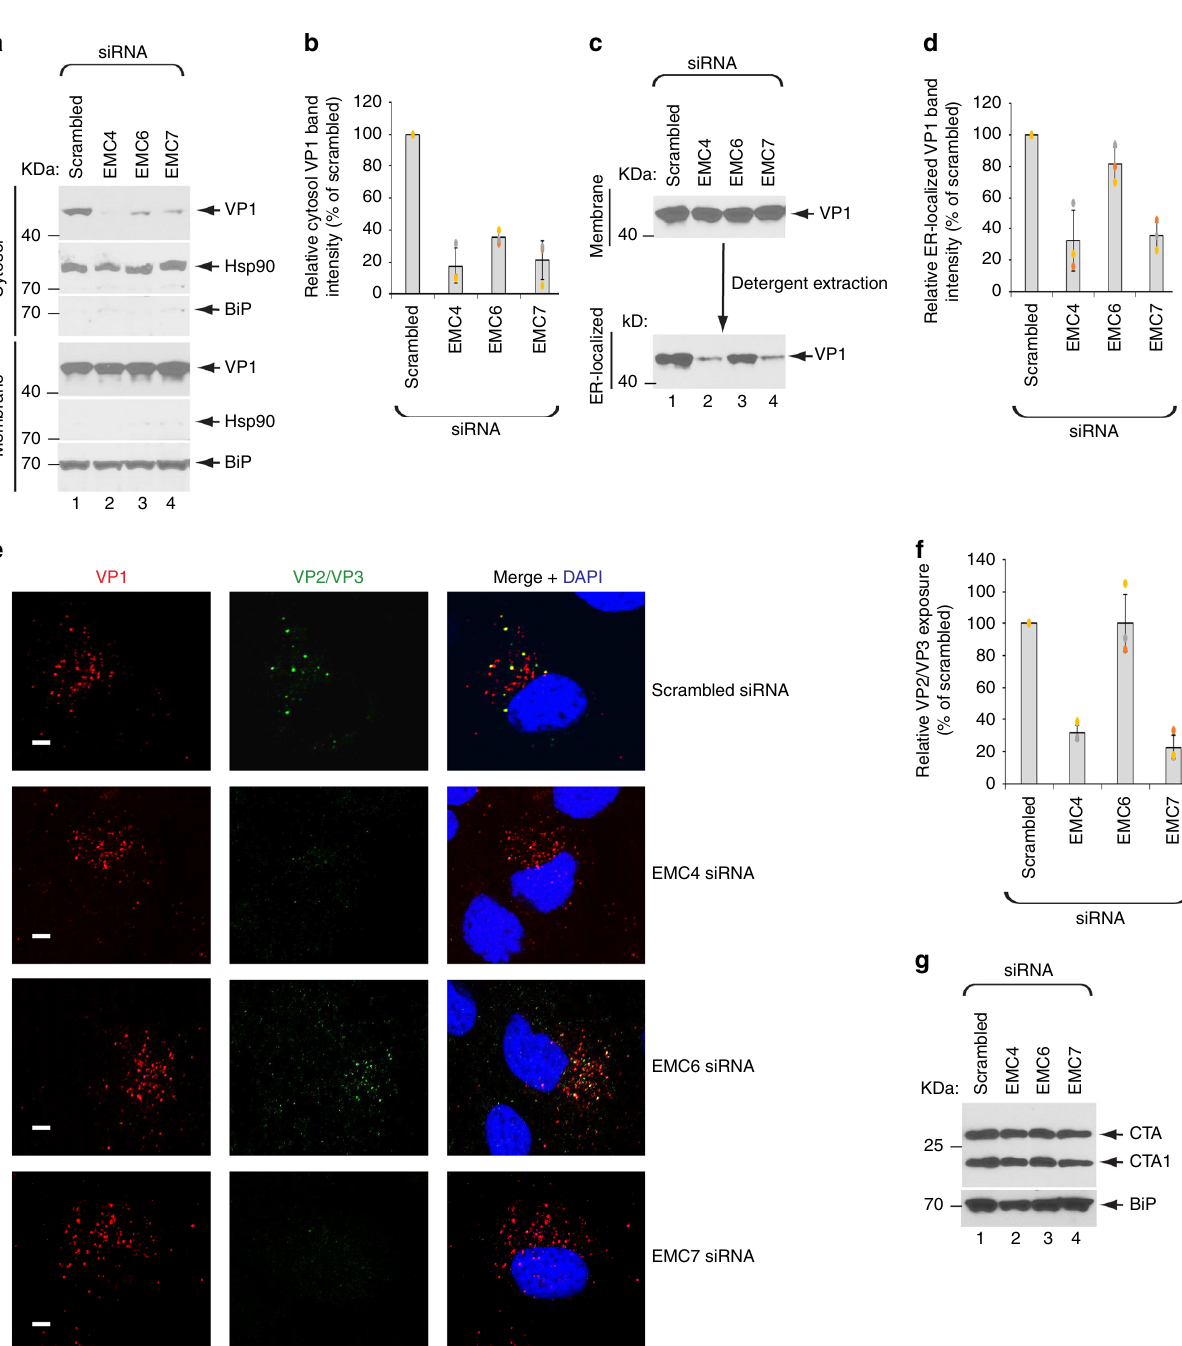
Fig. 2 EMC4 and EMC7 regulate ER-arrival of SV40 from the cell surface. a CV-1 cells transfected with the indicated siRNAs were infected with SV40 at MOI ~5, harvested, and subjected to the ER-to-cytosol membrane transport assay (see Materials and Methods). Cytosolic Hsp90 and ER-resident BiP were used as markers for the cytosol and membrane fractions, respectively. b Relative VP1 band intensities from the cytosol fraction in A were determined using FIJI/ImageJ. Data are normalized to scrambled siRNA. Values represent the mean ± SD of three independent experiments. c To isolate ER-localized SV40, the membrane fraction in A was solubilized in 1% Triton X-100, and the extracted material subjected to SDS-PAGE followed by immunoblotting with the VP1 antibody. d . Relative VP1 band intensities of ER-localized SV40 in C were determined using FIJI/ImageJ. Data are normalized to scrambled siRNA. Values represent the mean ± SD of three independent experiments. e CV-1 cells transfected with the indicated siRNAs were infected with SV40 (MOI ~0.5) and at 6 h post infection cells were fi xed, stained with the indicated antibodies, and analyzed by confocal microscopy. Scale bar = 10 µ m. f Relative VP2/VP3 exposure from the data in e was determined by quantifying VP2/VP3 signals normalized to the VP1 signals by FIJI/ImageJ, and displayed as the percentage of scrambled siRNA-treated sample. The image analysis was done on a single z-plane. Values represent the mean ± SD of three independent experiments. g CV-1 cells transfected with the indicated siRNAs were incubated with cholera toxin. Cells were harvested, lysed, and the resulting extract subjected to non-reducing SDS-PAGE and immunoblotted using the indicated antibodies. The experiment was repeated independently three times. Source data are provided as a Source Data fi